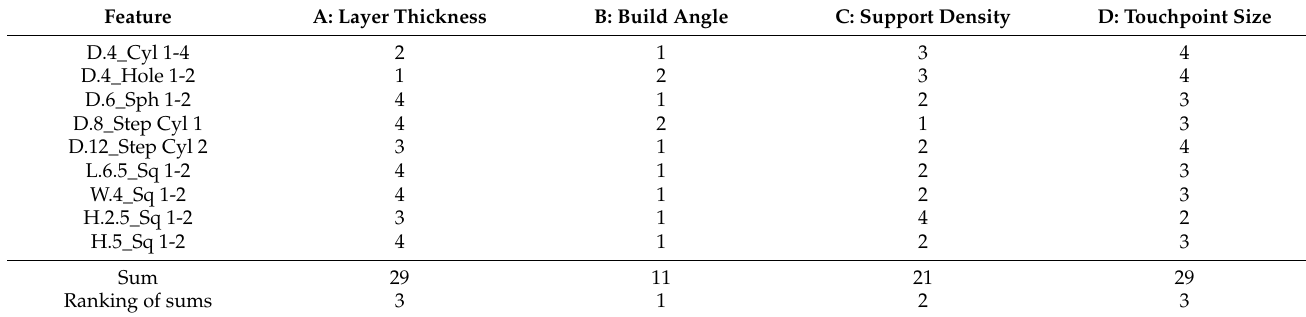
Table A1. Mean ranking of parameters for dimensional accuracy of patterns.